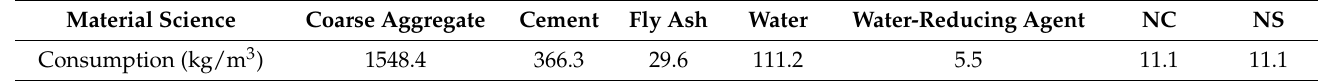
Table 3. Cubic meter consumption of materials.